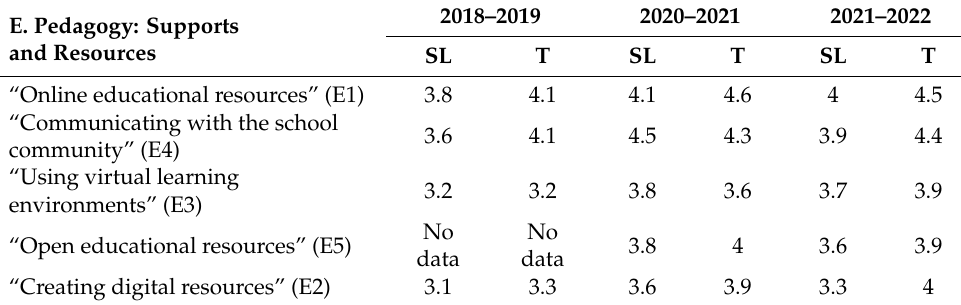
Table 6. Descriptive statistics on pedagogy: supports and